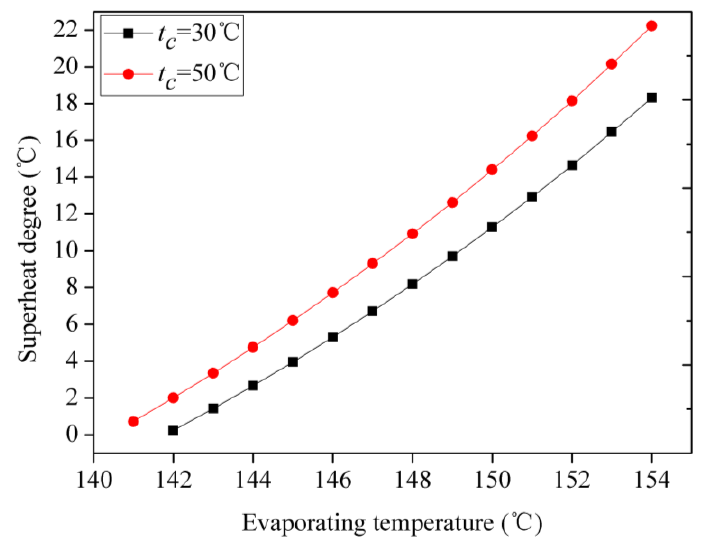
Figure 7. The minimum superheat degree required vs. evaporating temperature (R245fa).